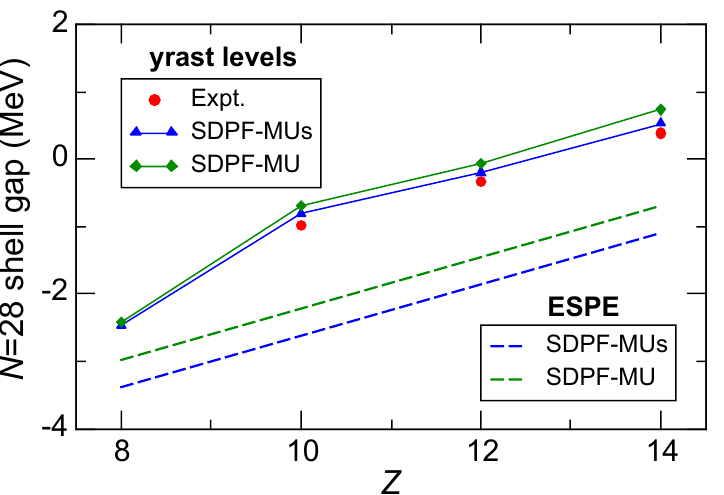
Figure 6. Evolution of the N = 28 shell gap in going from Z = 8 to 14 estimated from the ) − E x ( 7/2 − ) values in the N = 17 isotones (solid lines) and from the ESPE calculations E x ( 3/2 − 1 1 (dashed lines). Data are from Refs.